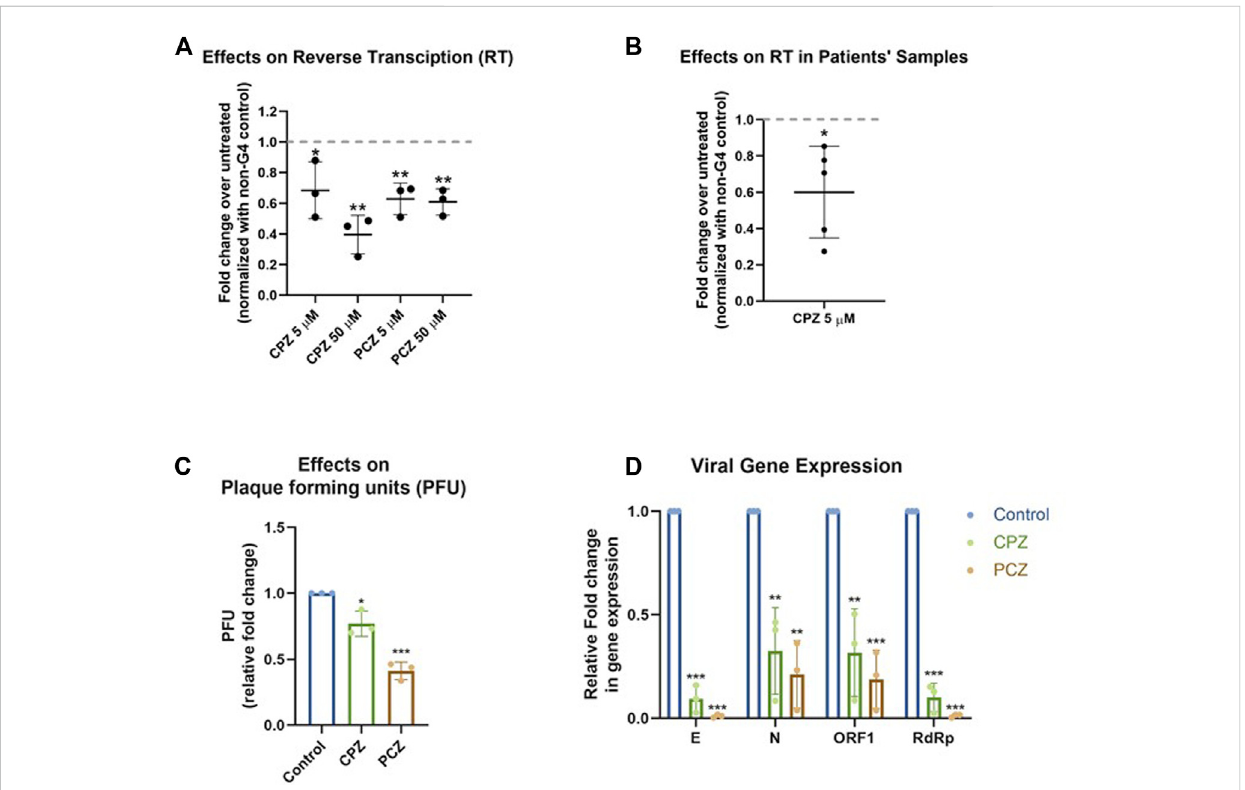
FIGURE 4 CPZ,PCZinhibitviralreplicationincells via G4binding. (A) FoldchangeinreversetranscriptionoftheORF1pG4-1harbouringregionoveruntreated control using a synthetic SARS-CoV-2 RNA: different concentrations of CPZ and PCZ were used; a non-G4 forming region was used for normalization. Mean ± SD (n = 3); unpaired, two-tailed t -test. (B) Fold change in reverse transcription of the ORF1 pG4-1 harbouring region over untreated control in RNA isolated from nasopharyngeal swabs of COVID-19 infected individuals, treated with 5 μ M CPZ; a non-G4 forming region was used for normalization. Mean ± SD (n = 3); unpaired, two-tailed t -test. (C) Fold change in plaque formation units (PFUs) indicating infectivity of supernatant from infectedVerocellstreatedwith5 μ MofCPZorPCZcomparedagainstuntreatedcontrol.Mean±SD(n=3);unpaired,two-tailed t -test. (D) Expression of the RNA levels of E, N, ORF1 and RdRp genes of SARS-CoV-2 in the extracellular media of infected Vero cells treated with 5 μ Mof CPZ or PCZ compared against untreated control. Mean ± SD (n = 3); unpaired, two-tailed t